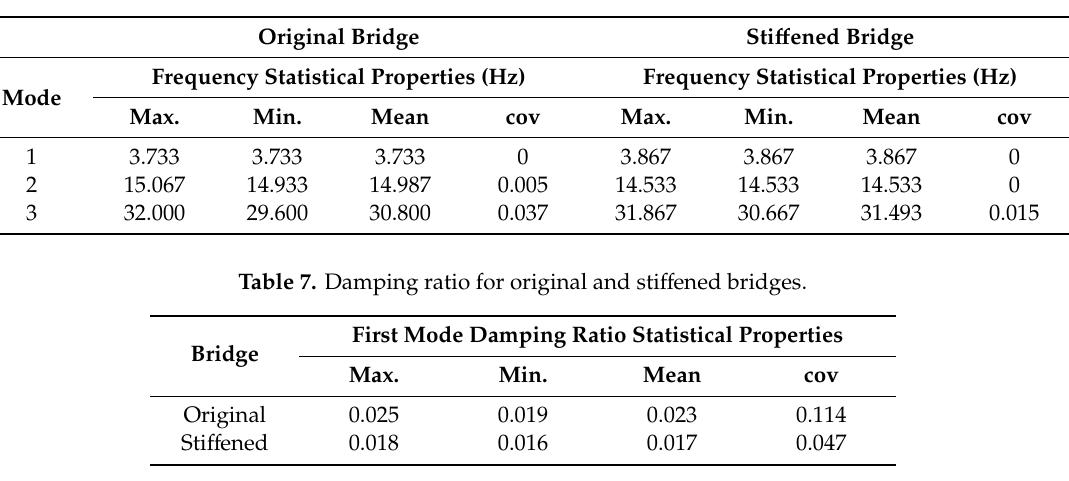
Table 6. Bridge frequency for the first three modes.